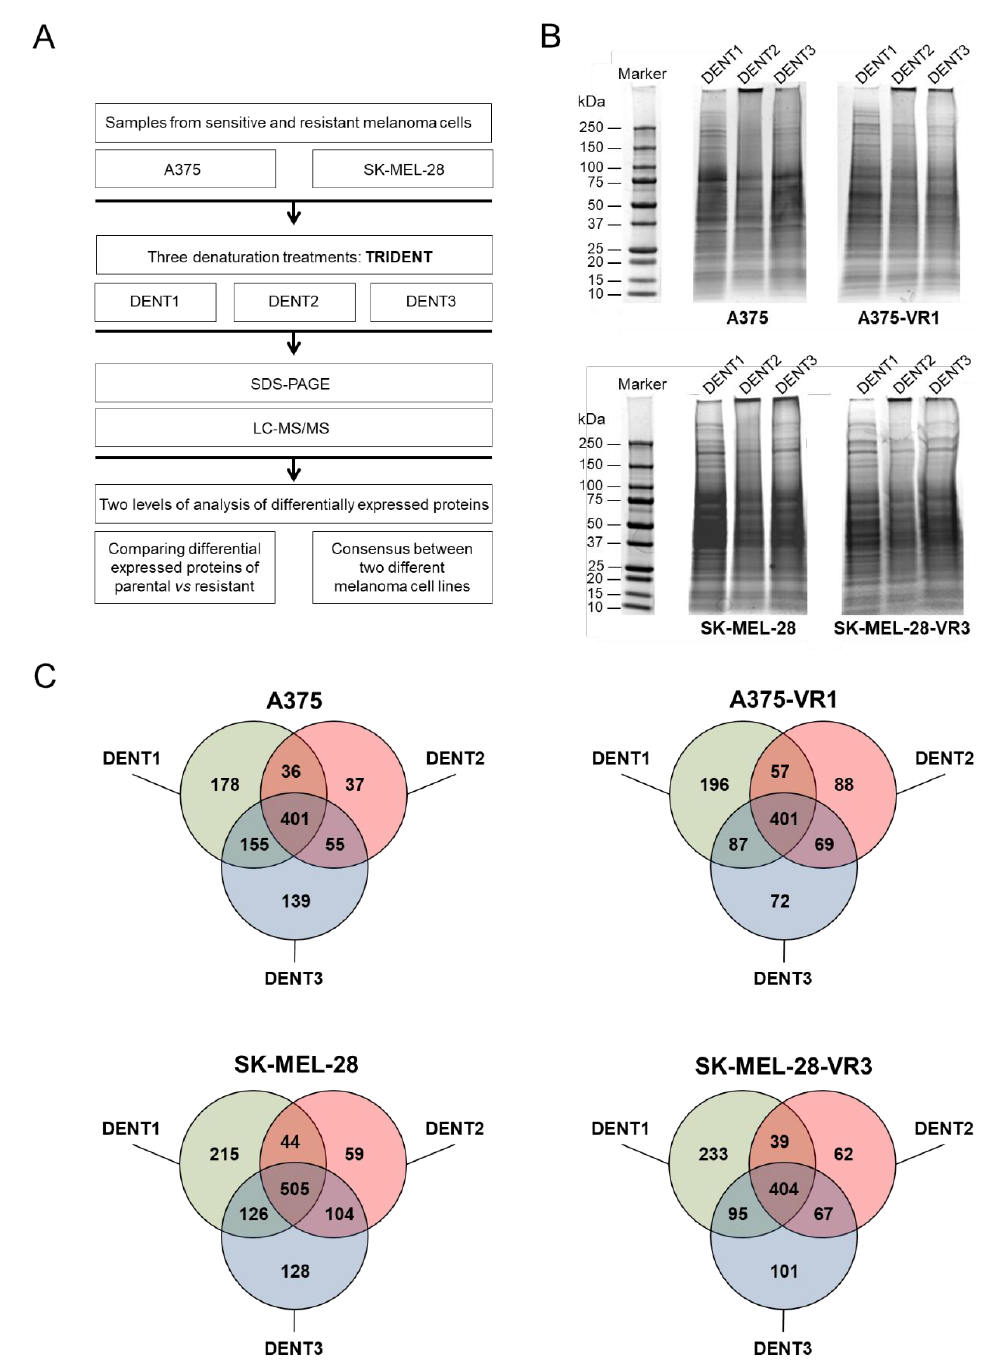
Figure 1. Comparative proteomic analysis of melanoma cells resistant and sensitive to vemurafenib. ( A ) Schematic representation of the experimental and analytical workflow for this study. ( B ) Representative electrophoretic separation of cell lysates after application of TRIDENT differential denaturation protocol. Samples were run on pre-cast gradient gel and stained by Coomassie Blue G-250. Different protein bands were detected after DENT1, DENT2, and DENT3 pre-treatments. ( C ) The entire protein gel lanes were excised, cut, and trypsin-digested, and proteins were identified through LC-MS/MS analysis (LTQ). Venn diagrams show the numbers of proteins overlapping among the three different denaturation protocols for A375 and SK-MEL-28 parental and resistant cells.